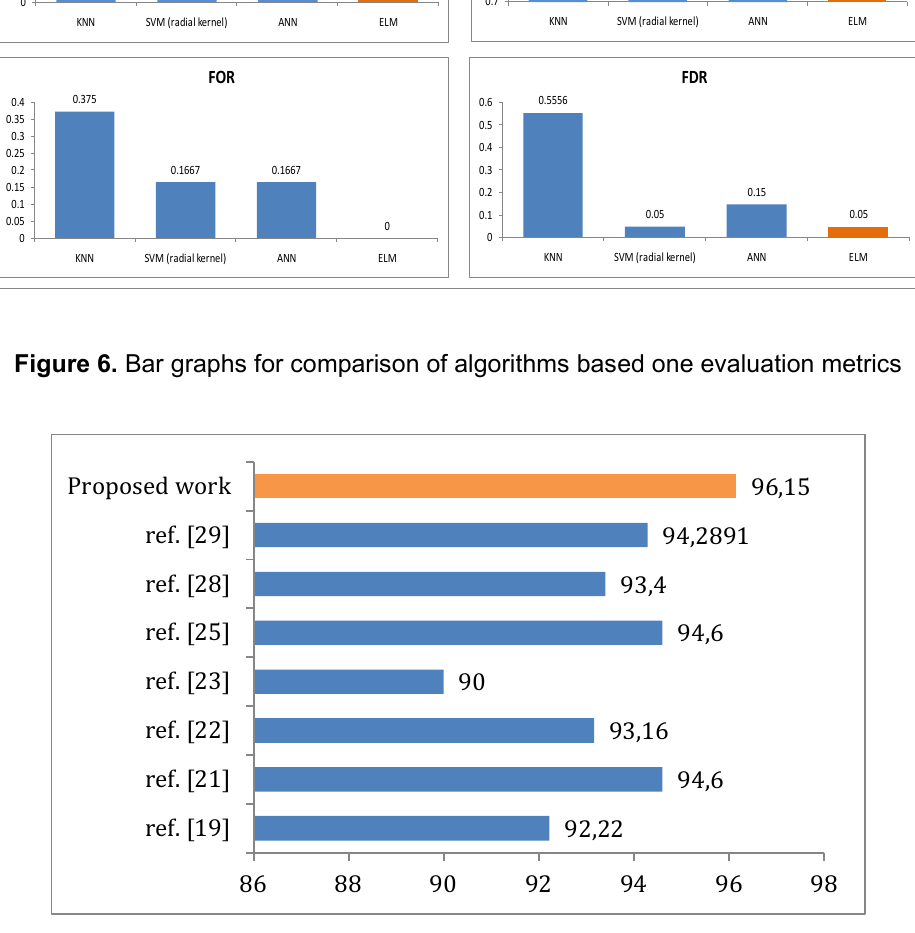
Figure 7. Comparison of literature work and proposed work on the basis of